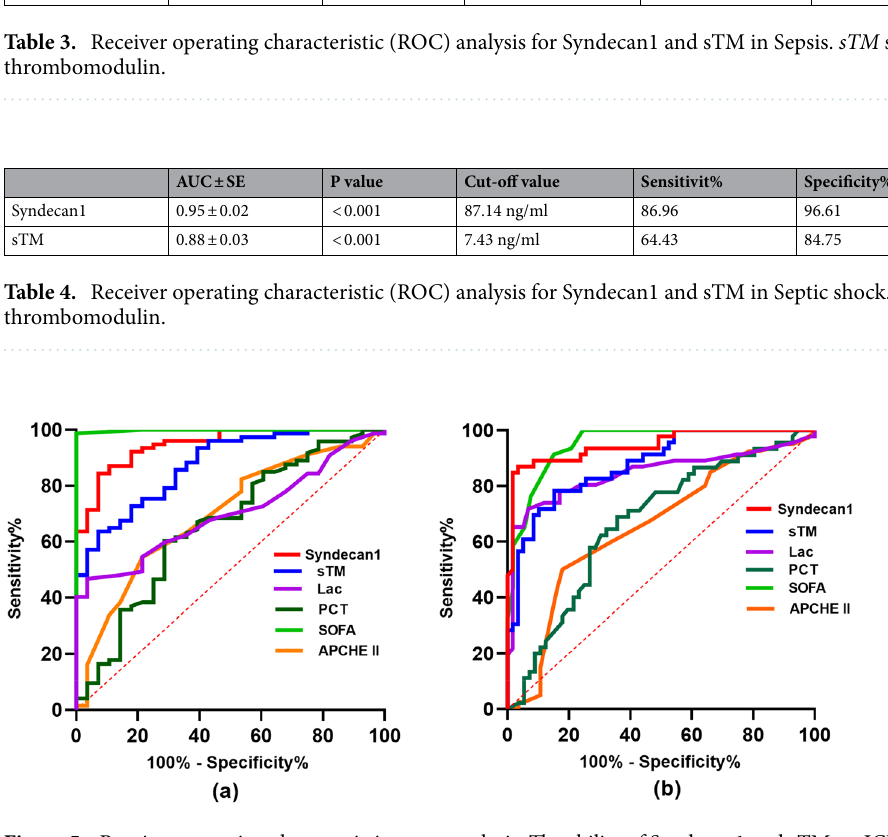
Figure 5. Receiver operating characteristic curve analysis. The ability of Syndecan1 and sTM on ICU admission to predict the incidence of sepsis ( a ) or septic shock ( b ). sTM serum thrombomodulin, ICU intensive care unit, ICU intensive care unit, APACHE II score Acute Physiology and Chronic Health Evaluation II score, SOFA sequential organ failure assessment score, Lac lactate, PCT